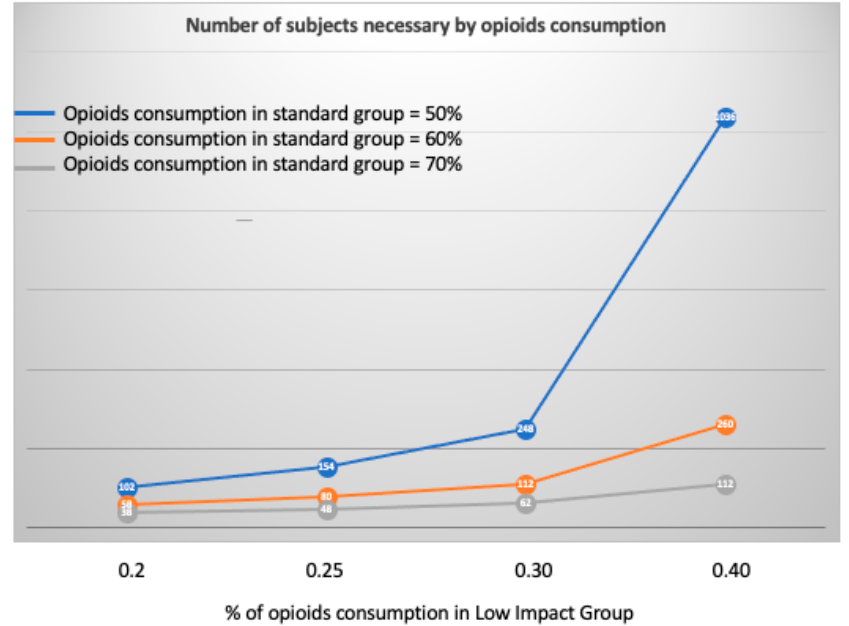
Figure 2. Theoretical number of patients necessary to demonstrate in a trial the benefit of low impact procedure on opioids consumption.